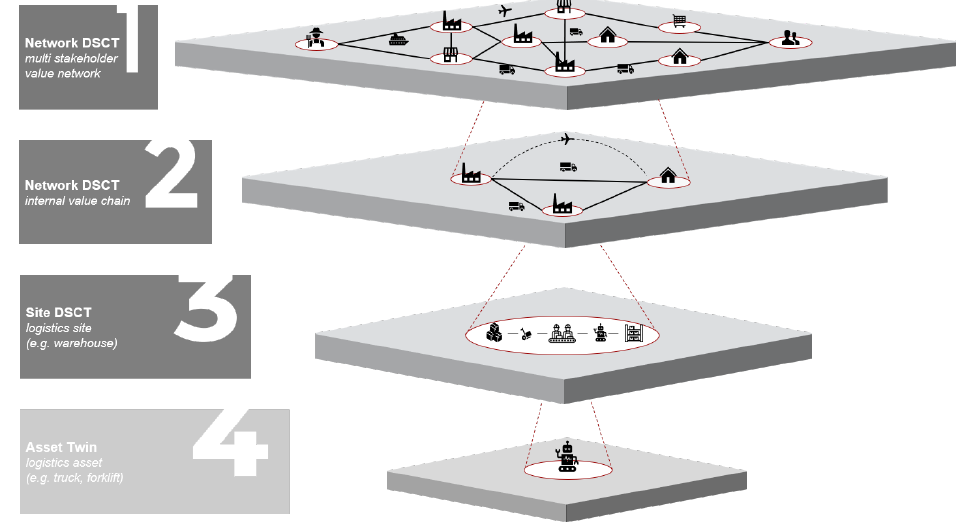
Figure 3. Relation of DSCTs and granularity of the supply chain (cf.